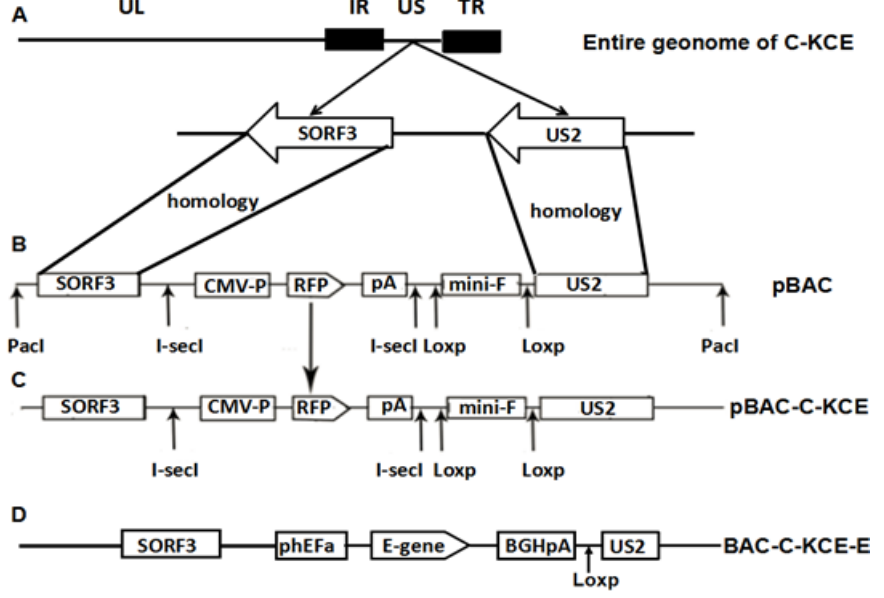
Figure 1. ( A ) The organization of the 158-kbp attenuated commercial duck enteritis virus (DEV) vaccine strain (C-KCE); ( B ) the organization of